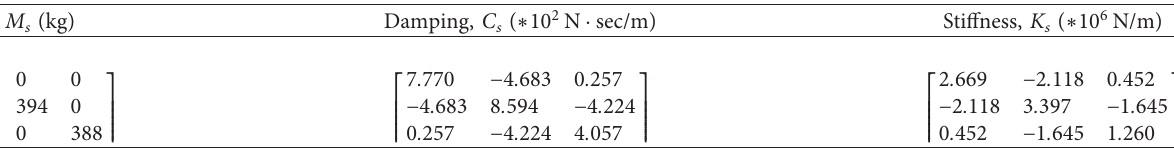
Table 7: Utilized damper properties in the model [40].